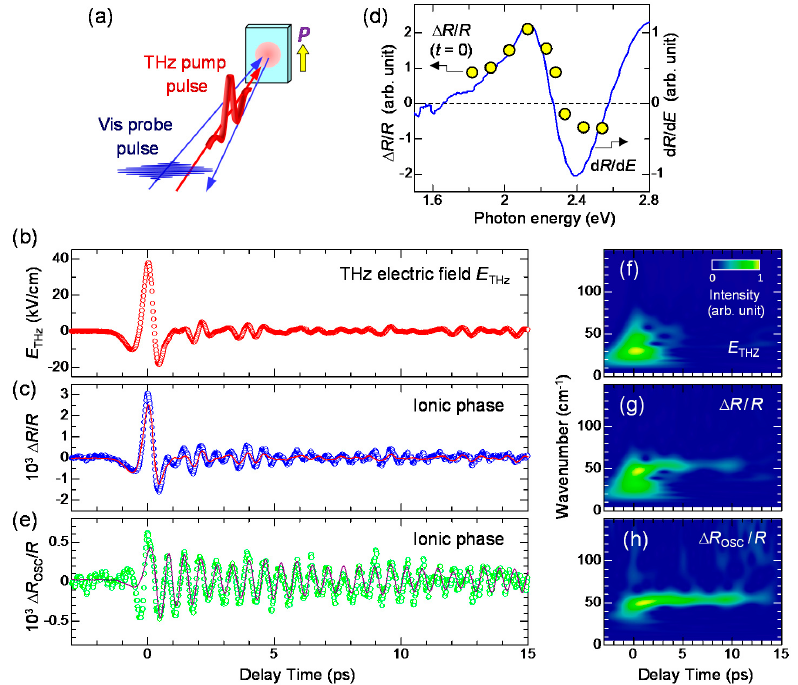
Figure 21. Results of terahertz-pump optical-reflectivity-probe measurements in the ferroelectric I phase of TTF-CA [41]. ( a ) Schematic of terahertz-pump optical-reflectivity-probe measurement; ( b ) an electric-field waveform of a terahertz pulse ( E THz ); ( c ) time evolution of reflectivity changes Δ R / R at 78 K in the ionic phase (circles) and the normalized E THz ( t ) (the solid line) in TTF-CA [41]; ( d ) probe energy dependence of Δ R / R at the delay time t d = 0 ps and at 78 K (yellow circles). The solid line shows the first derivative (d R /d E ) of a reflectivity spectrum at 77 K with respect to the photon energy E , which shows the reflectivity change due to a slight increase in ρ ; ( e ) an oscillatory component Δ R OSC ( t )/ R (circles) and fitting curve (solid line); ( f – h ) time-dependent Fourier power spectra (wavelet transforms) of (b), E THz ( t ) (c), Δ R / R ( t ), and (e) Δ R OSC / R ( t ), respectively.